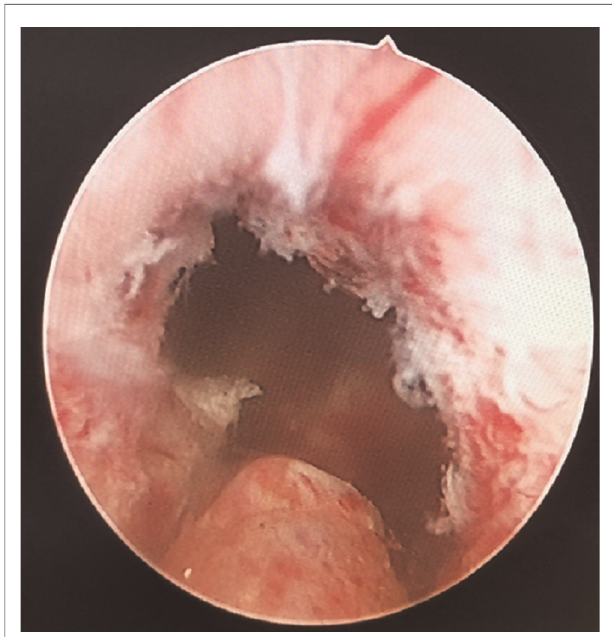
FIGURE 2 | By annularly dissecting the urethral mucosa about 0.5 cm from the apex of the prostate, the urethral mucosa adjacent to the LEEP loop is damaged, whitened and denatured when the electric current is applied.